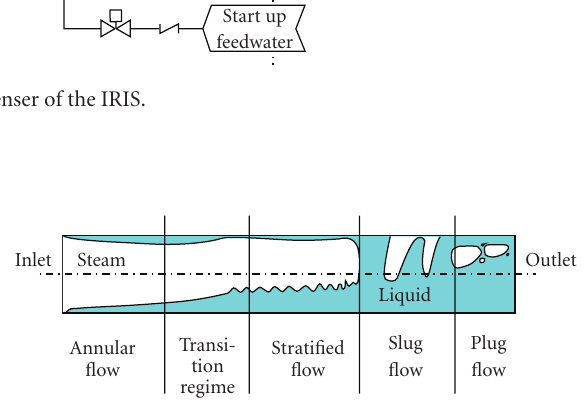
Figure 6: Di ff erent flow patterns during condensation in a horizontal